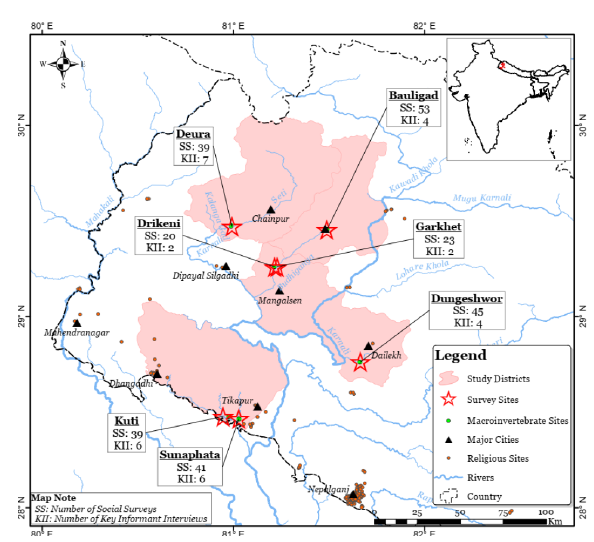
Fig. 3. Locations of sites selected for social